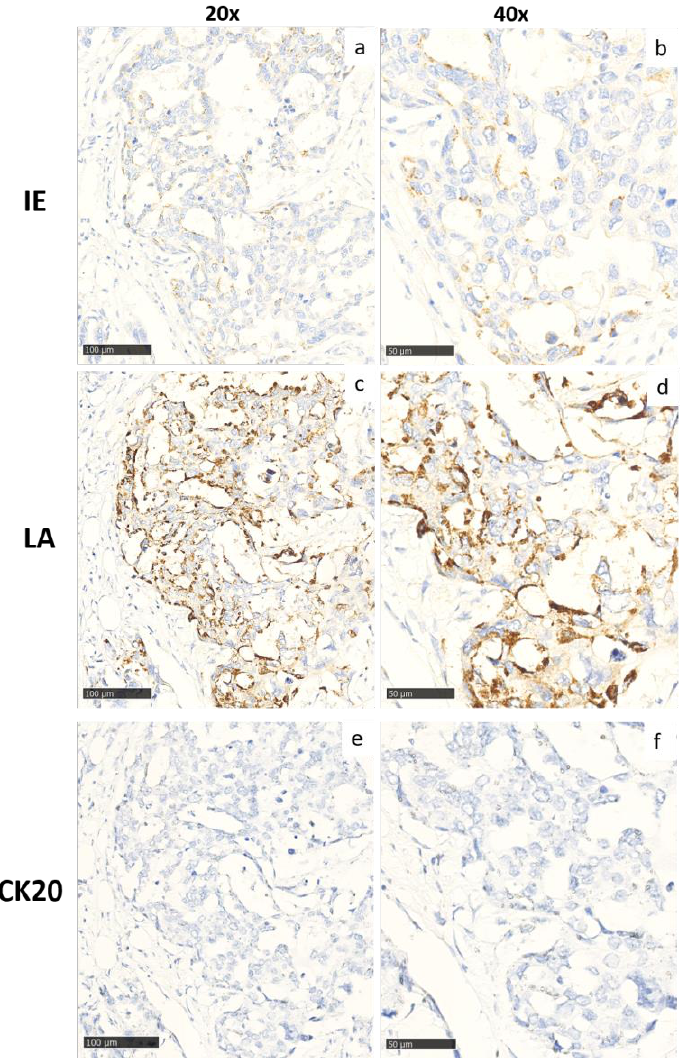
Figure 1. Representative images at two different magnifications (20x; ( a , c , e ) and 40x; ( b , d , f )) of the automated immunostaining for HCMV-IE ( a , b ) and HCMV-LA ( c , d ) and Cytokeratin-20 (CK-20; ( e , f ) used as a control) in breast cancer. Cytoplasmic staining is observed for both HCMV proteins. In this analysis, LA was more widely and strongly expressed, while IE was more selectively expressed. Table 2. Scores of immunohistochemical staining for HCMV IE and HCMV LA, in the breast cancer samples.